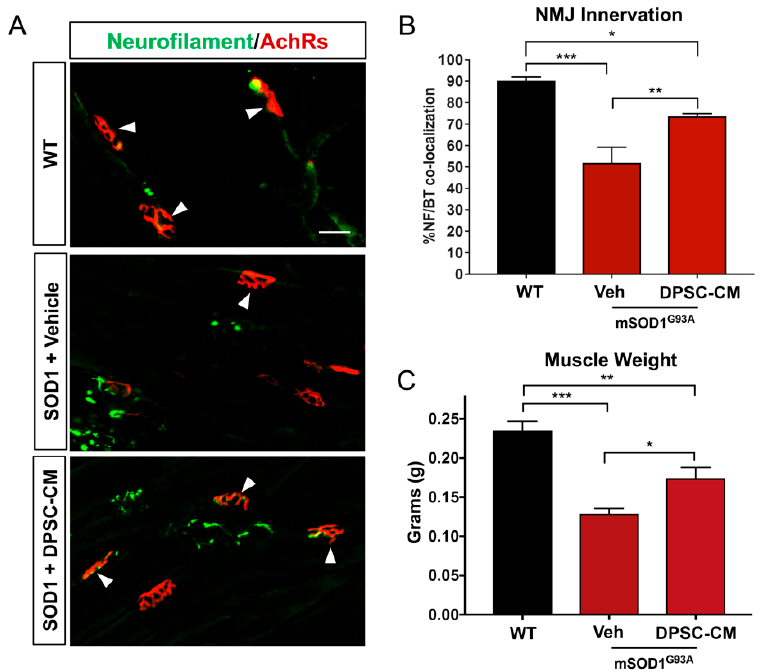
Figure 3. Late pre-symptomatic DPSC-CM therapy significantly improved NMJ innervation mSOD1 G93A mice. Administration of DPSC-CM from PD70–91 ( A , B ) significantly increased innervated NMJs in the medial gastrocnemius (white arrowheads), as well as ( C ) total wet muscle weight compared to vehicle-treated mice. Data represent mean +/ − SEM. Data analyzed via one-way ANOVA. (WT, n = 3; mSOD1 G93A , n = 5–6). *, p < 0.05; **, p < 0.01; ***, p < 0.001. Scale bar = 50 µ m. Brain Sci. 2019 , 9 , x FOR PEER REVIEW